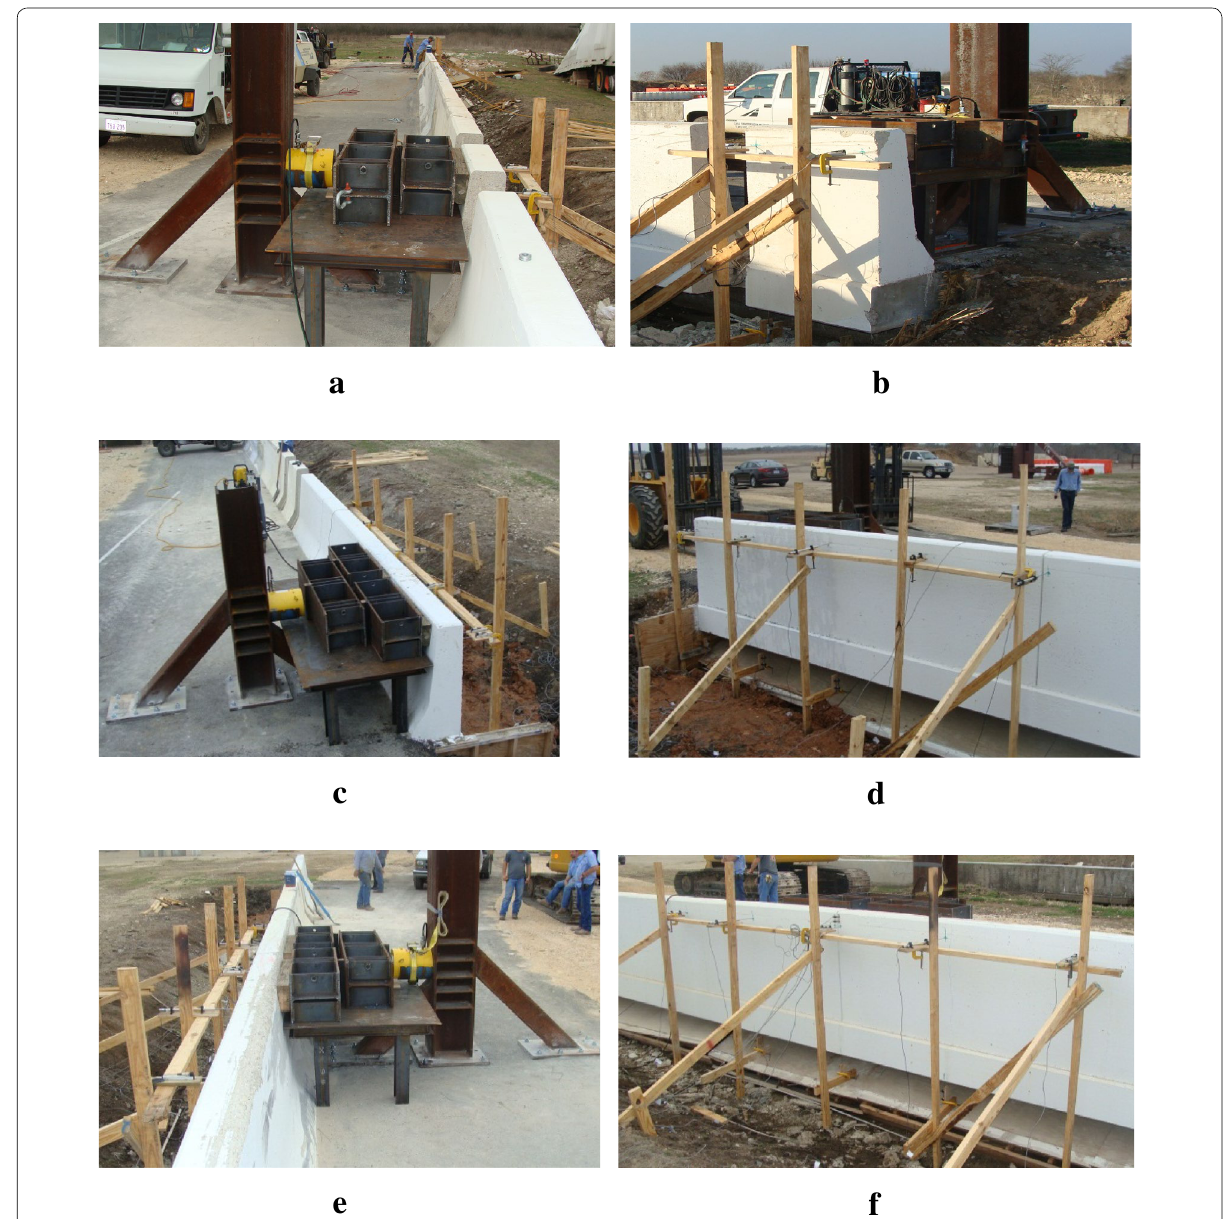
Fig. 5 Views of the test setups for constructed barrier. a Test setup for 1000 mm length barrier wall at interior location, b test setup for 1000 mm length barrier wall at exterior location, c test setup for the barrier wall loaded over 2400 mm length at exterior location, d back side of the exterior 2400 mm loaded length showing sensor supporting frame, e test setup for the barrier wall loaded over 2400 mm length at interior location, f back side of the interior 2400 mm loaded length showing sensor supporting